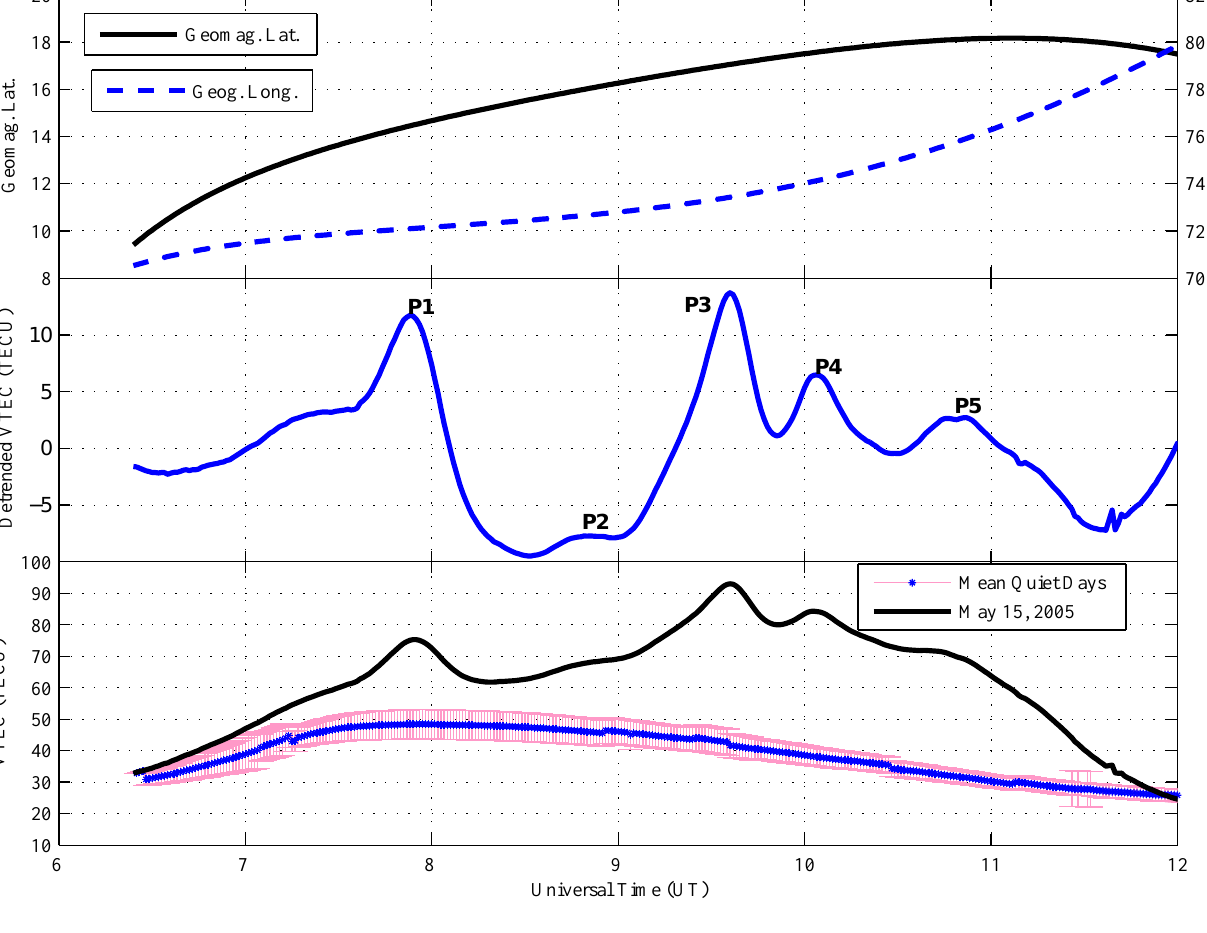
Fig. 3a. VTEC observations from Udaipur for PRNs 14. The VTEC curve on 15 May 2005 (black solid) is shown in comparison with the mean VTEC (blue dotted) in the bottom panel. Vertical bars (magenta) of 1 σ on mean VTEC curve represent the standard deviation for estimated mean. Middle panel shows the detrended VTEC obtained by detrending the VTEC of 15 May with a polynomial fit. The Uppermost panel in the figure shows the Geomag. Lat. (left ordinate-black curve) and Geog. Long. (right ordinate-blue dashed curve) for the IPPs for the pass of GPS satellite,